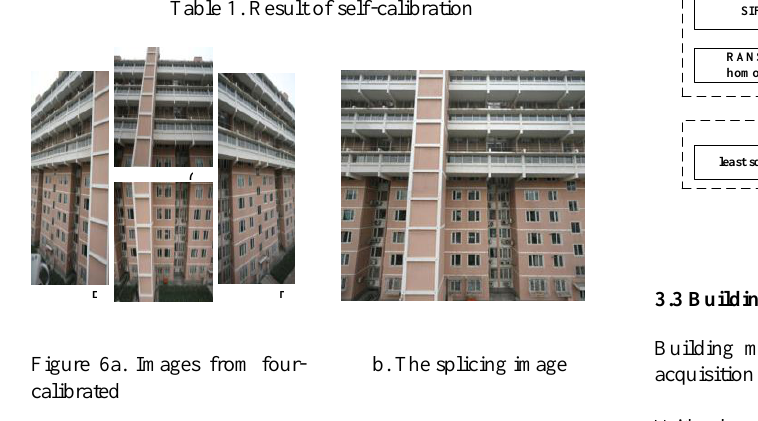
Table 1. Result of self-calibration